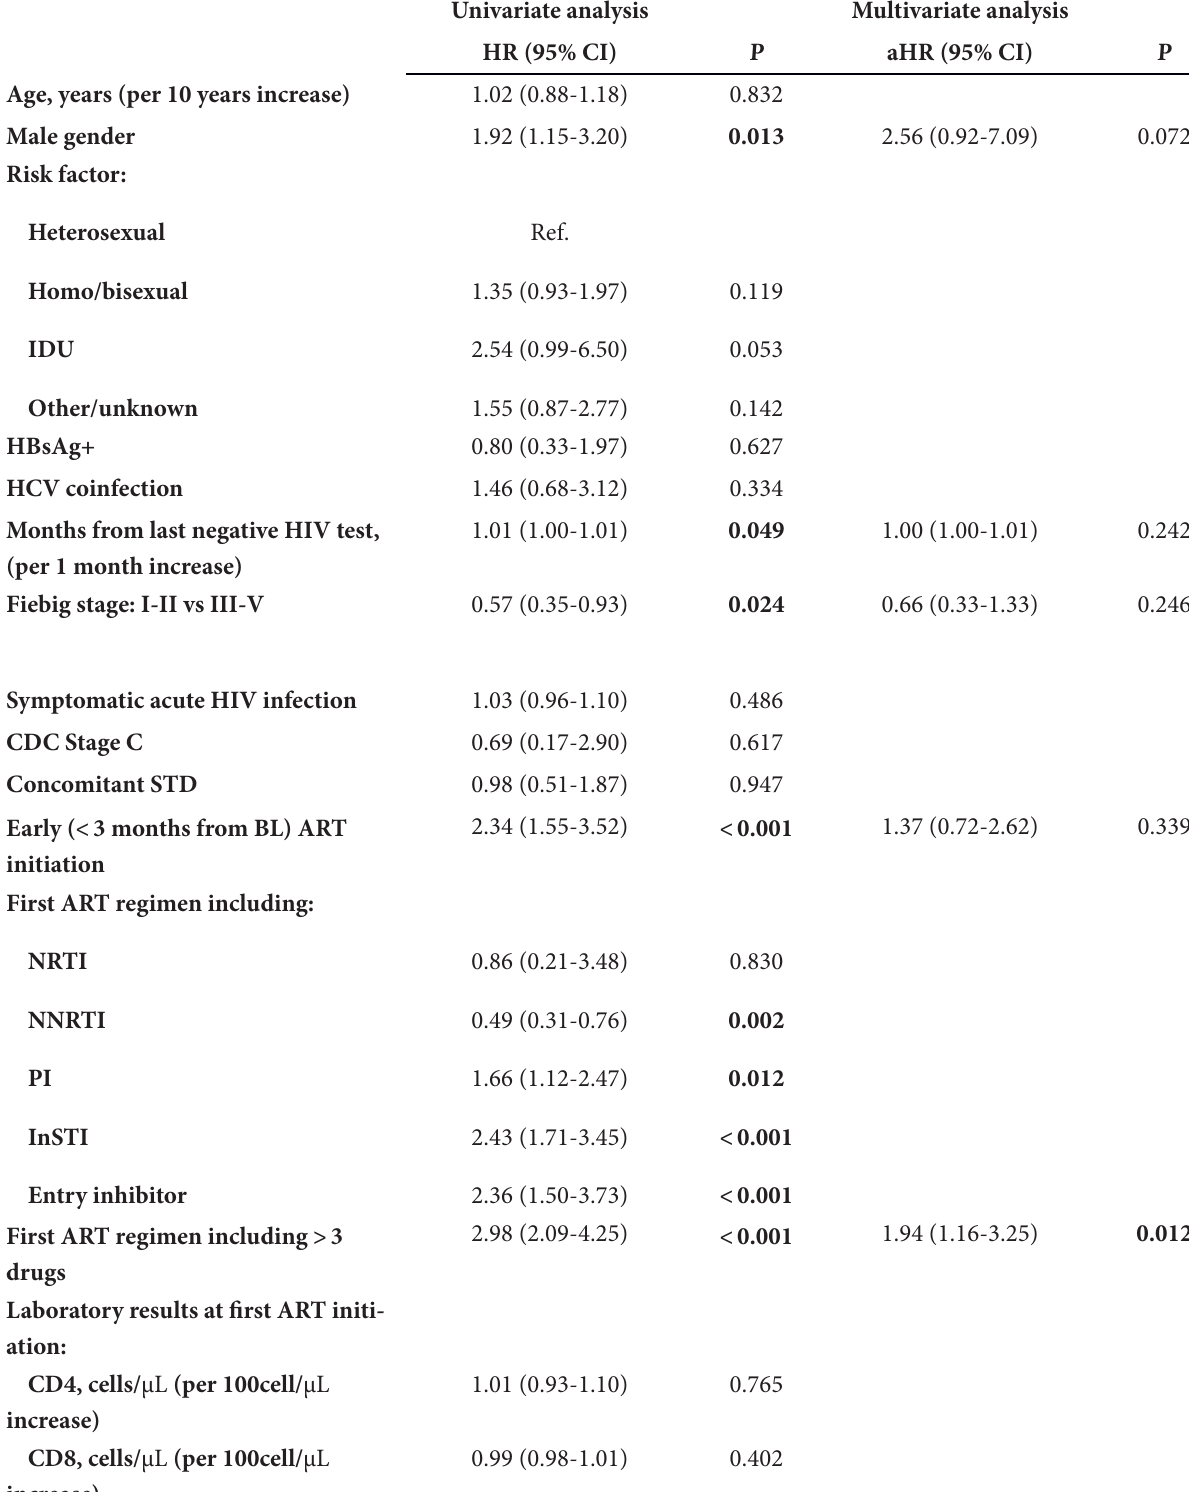
Table 5. Predictors of time to first-line regimen discontinuation (Cox regression